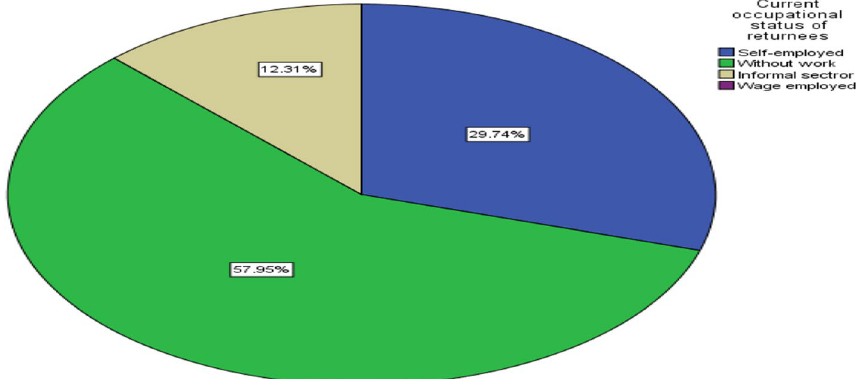
Fig. 3 Percentage distributions of current occupational status of returnees. Source Field Survey Result,